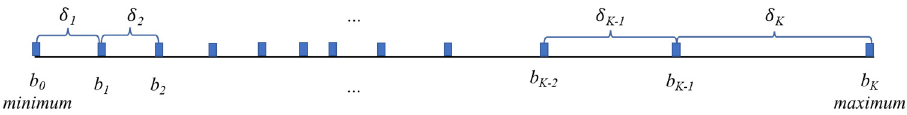
Figure 2. Break points and the corresponding intervals for geometric interval classifier.